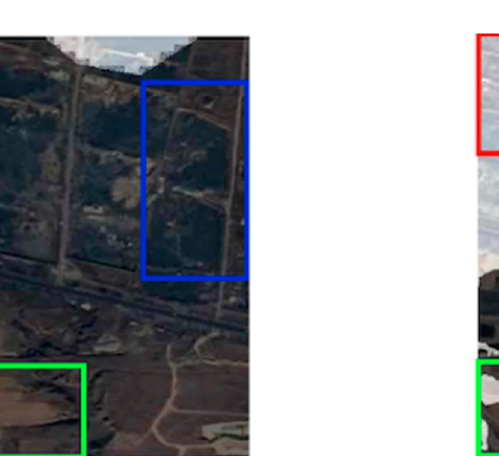
Figure 9. Some building segmentation results of different methods.